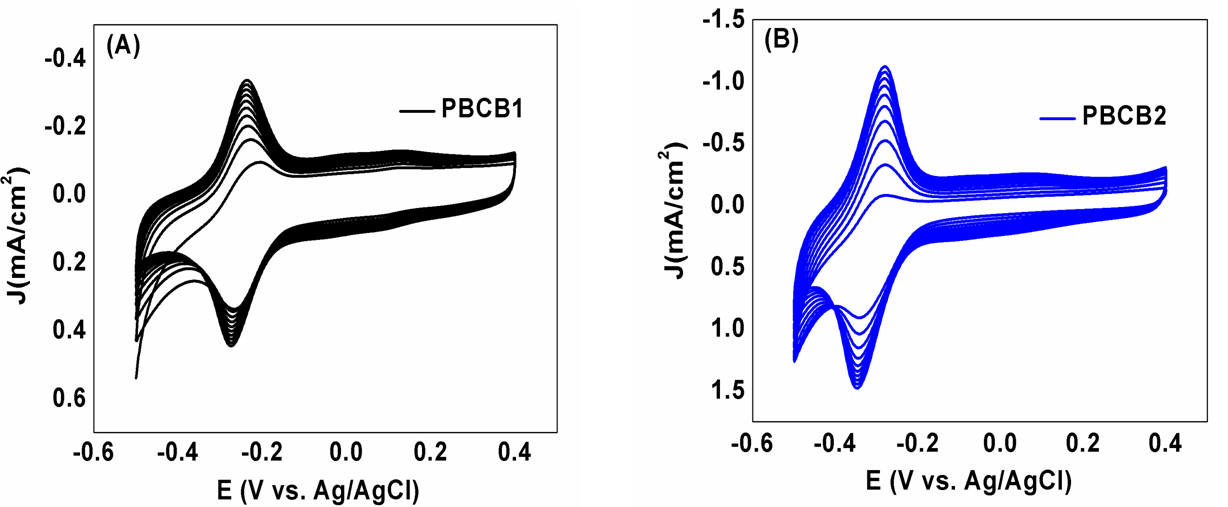
Figure 1. CVs for the electropolymerization of BCB onto AGCE in two different activation ways: one-step activation, PBCB1 ( A ) and two-step activation PBCB2 ( B ) in 0.1 MPBS (pH 7.0).